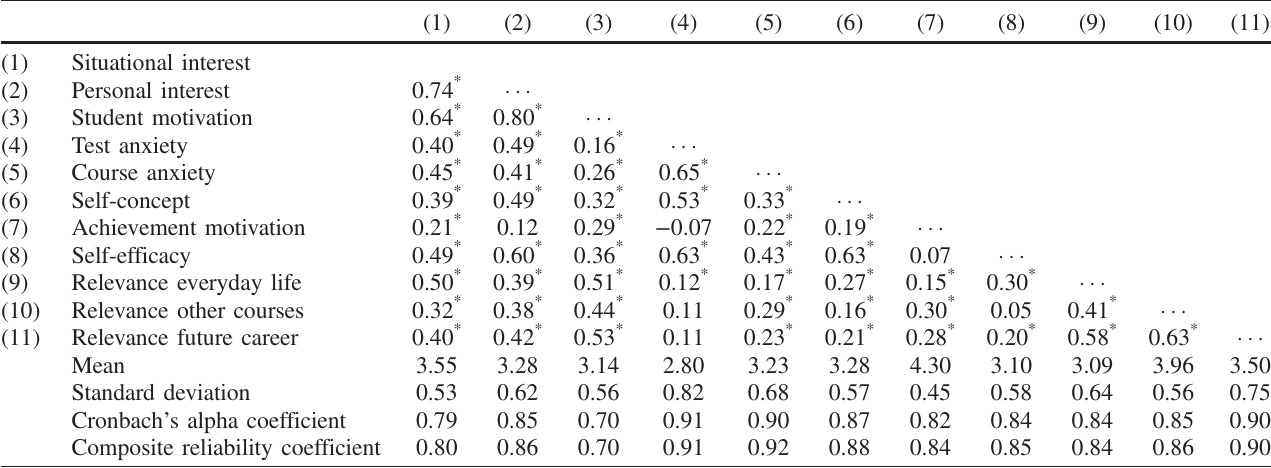
TABLE III. Intercorrelations (corrected for measurement error) among the affective